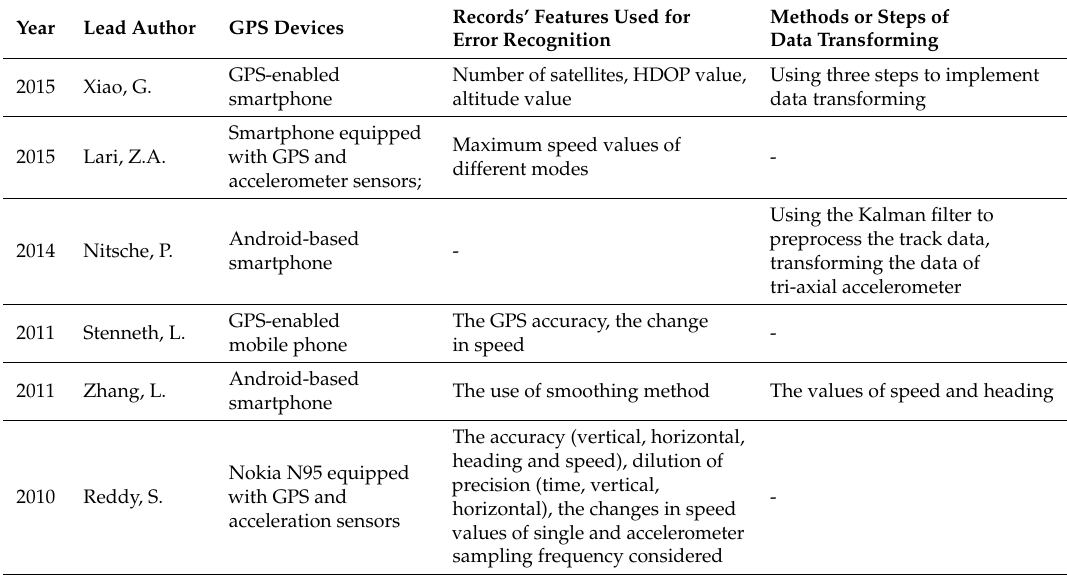
Table 3. Summary of data error recognition and preprocessing in the selected